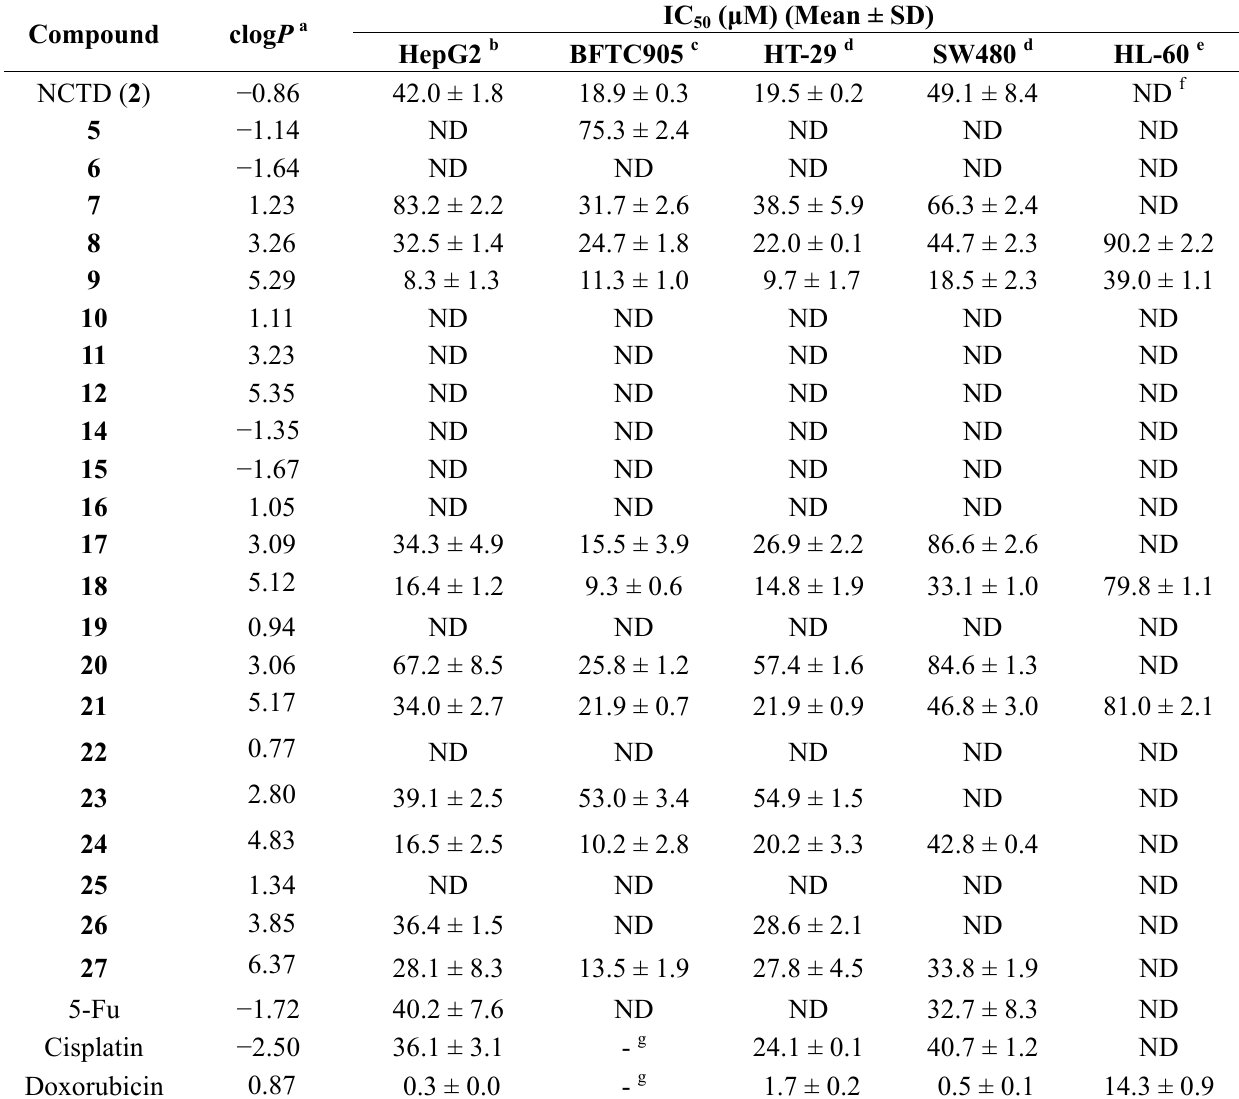
Table 1. Cytotoxic effects (IC values in μ M) of norcantharidin ( 2 ) and its derivatives 50 ( 5 – 12 , 14 – 27 ), 5-Fu, cisplatin and doxorubicin against five human cancer cell lines for 48